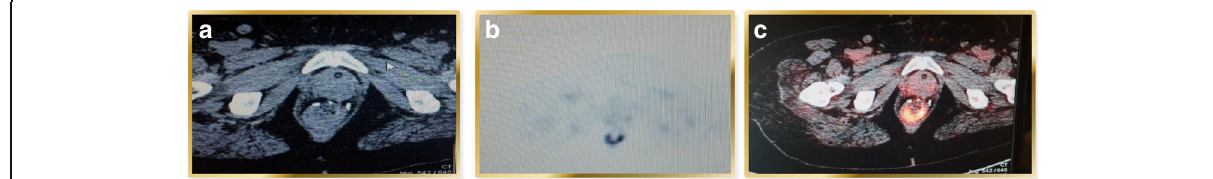
Fig. 3 a Post-operative CT study showing mild Hatman pouch anastomotic site mural thickening. b PET image with focal C shaped FDG uptake within the posterior aspect of the anastomotic site. c PET/CT fused image with avid uptake by the visual assessment method